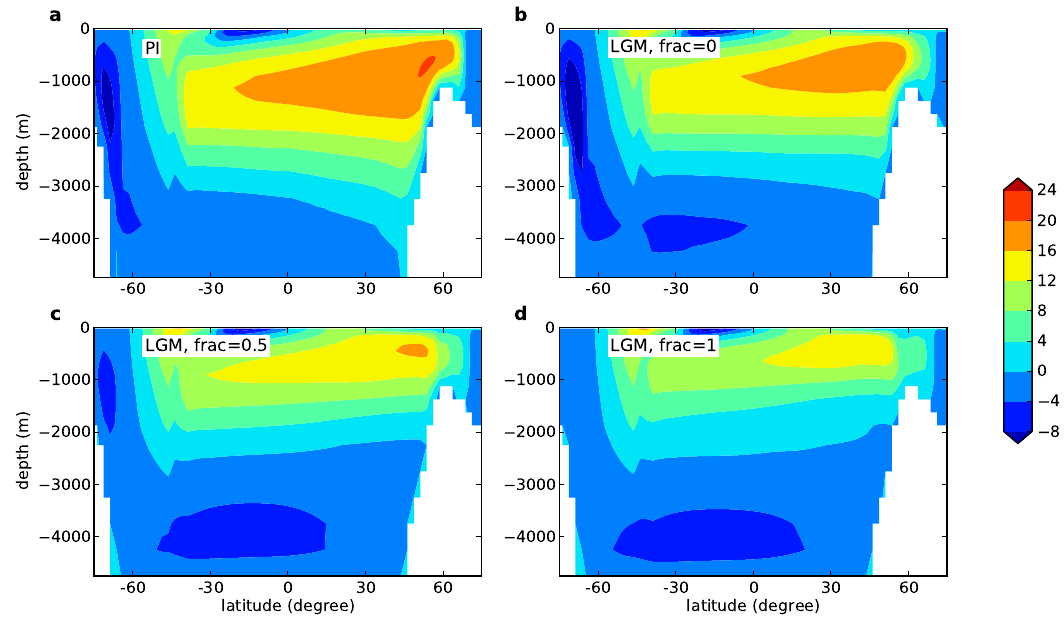
Fig. 4. Simulated meridional overturning stream function (Sv) in the Atlantic for (a) the Pre-industrial (PI) simulation, (b) the standard LGM simulation (LGM-std) with frac =0 (no impact of brines), (c) the LGM simulation with frac =0.5 (medium impact of brines), (d) the LGM simulation with frac =1 (maximum impact of brines).